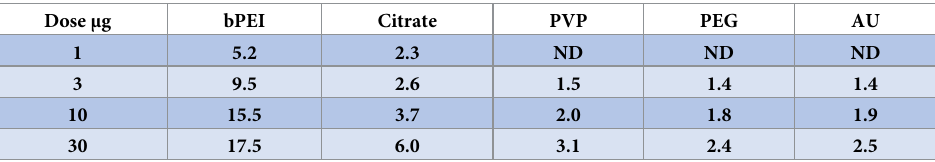
Table 1. SSC measurements of cells treated with AgNP and